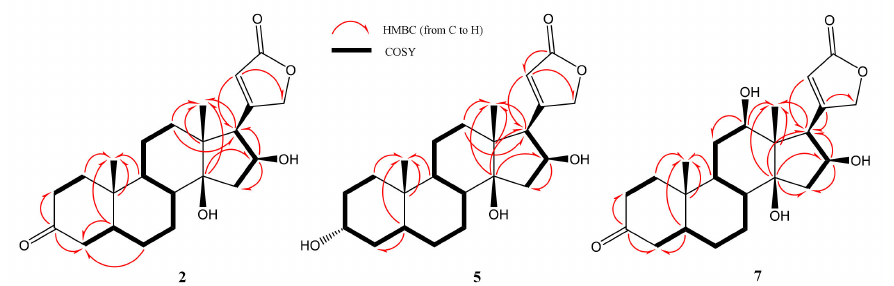
Figure 4. Key HMBC and COSY correlations of the known metabolites (compounds 2 , 5 and 7 ) obtained from the microbial biotransformation of gitoxigenin by A. eureka